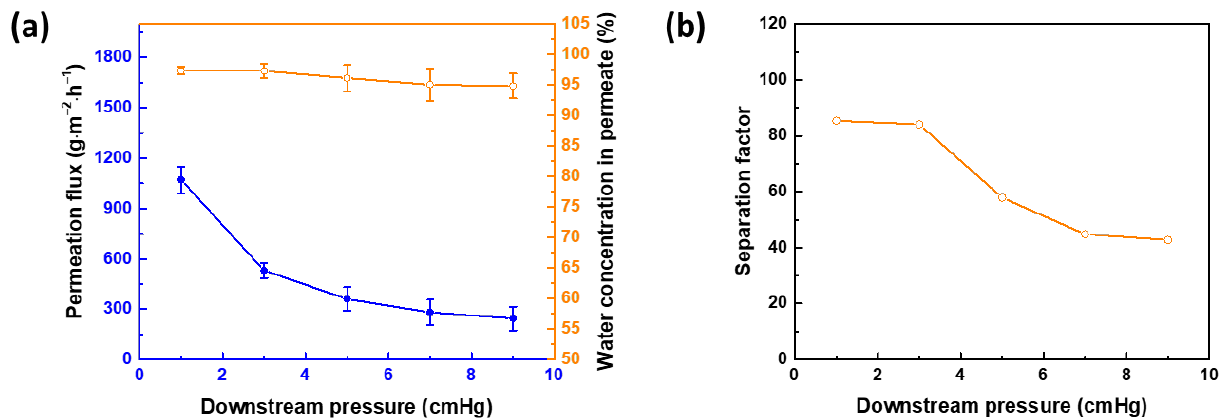
Figure 8. Membrane performance at different downstream pressures, in terms of ( a ) permeation flux and water concentration in permeate and ( b ) separation factor. APTMOS/CHDA ratio = 0.15; mixing time = 60 min; reaction temperature = 30 °C; concentration of IPA = 70 wt%; and operating temperature = 25 °C.